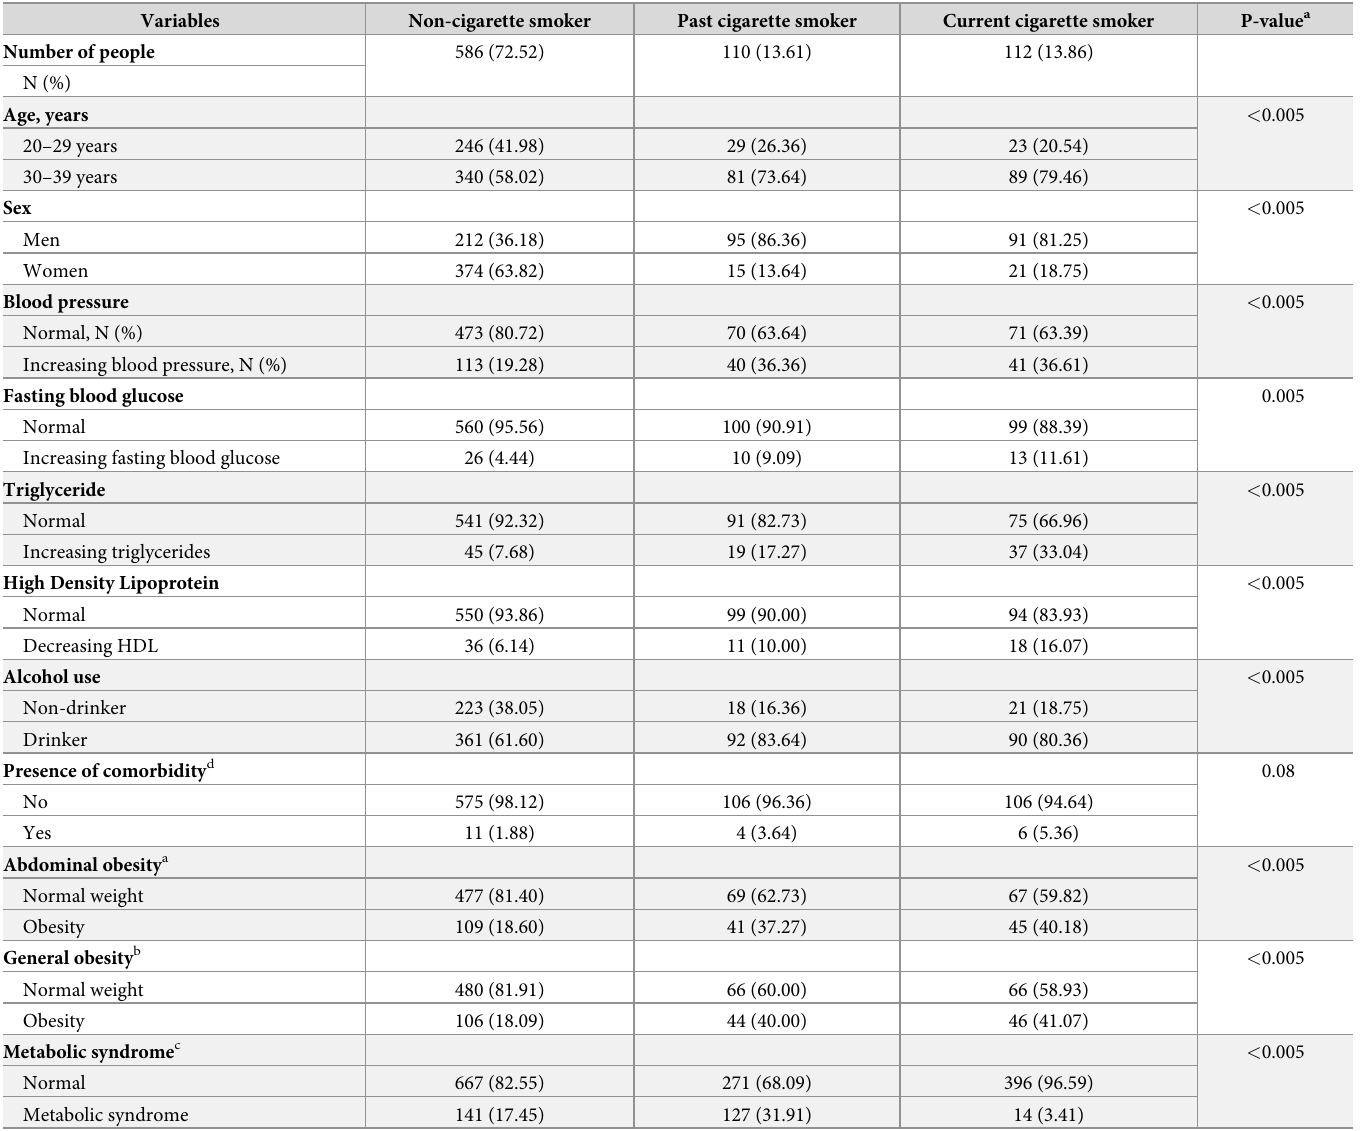
Table 2. Comparison of subject characteristics according to smoking